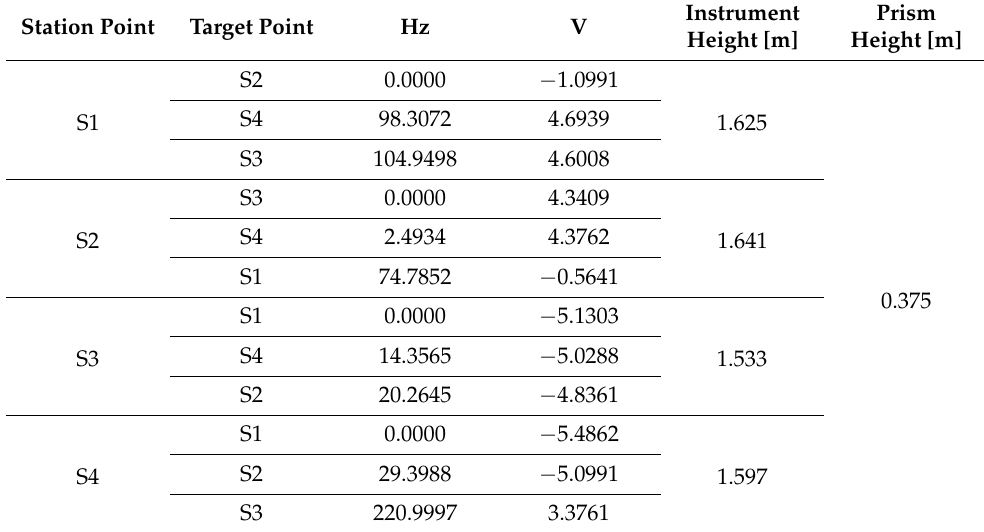
Table A8. The angular observations after 1 year (2018).